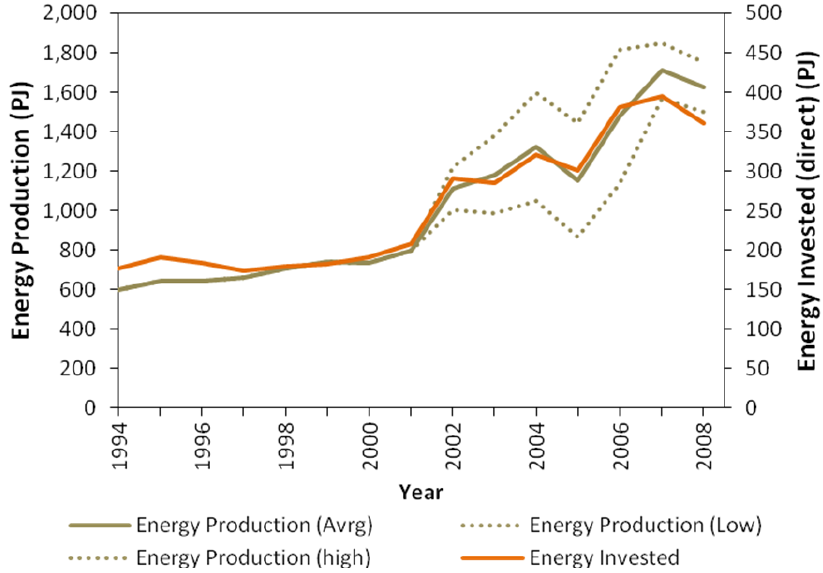
Figure 4. Energy Return and Energy Invested in Tar Sands (Surface Mining). The dashed lines represent high and low estimates for production, a discrepancy due to the combination of two